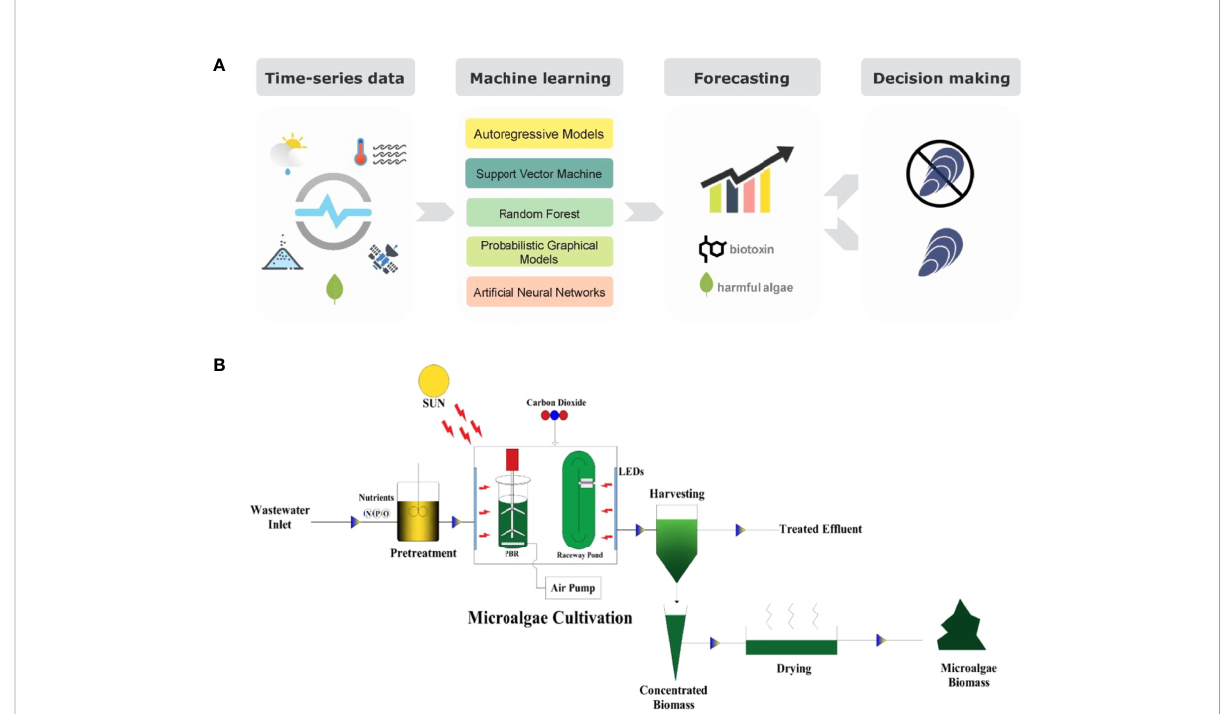
FIGURE 7 (A) Block diagram of Shell fi sh contamination prediction based on machine learning. (reproduced with permission from an open access article). (B) Process diagram of wastewater treatment with microalgae. (reproduced with permission from Singh and Mishra,